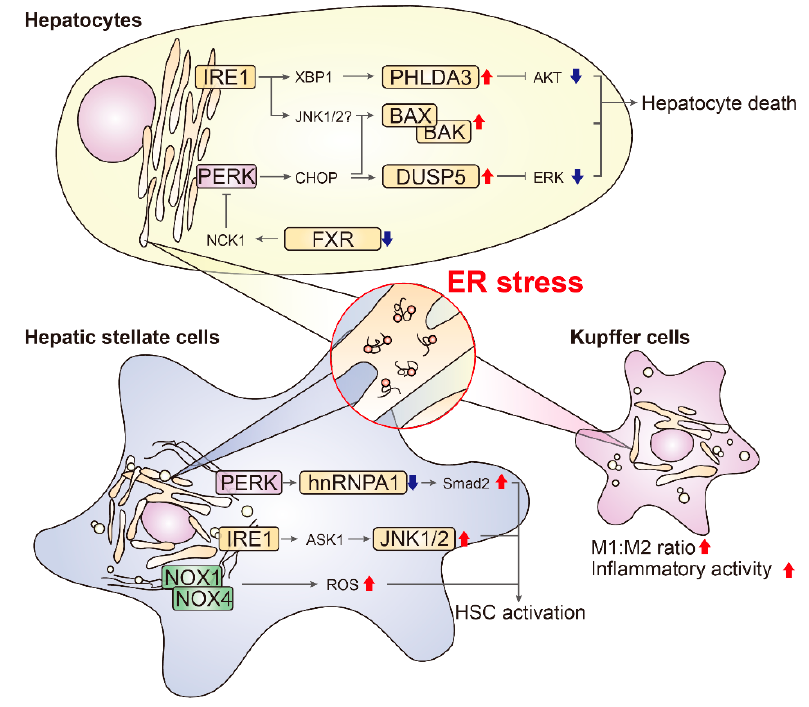
Figure 2. Cell-type specific molecular effectors of ER stress signaling in liver disease. ER stress- mediated signaling and the driver of pathogenesis varies across types of liver cells. Grey arrows indicate stimulatory (tipped) or inhibitory (blunted) interaction. Red upward and blue downward arrows indicate changes in key molecules or events that occur in cells that have experienced ER stress.